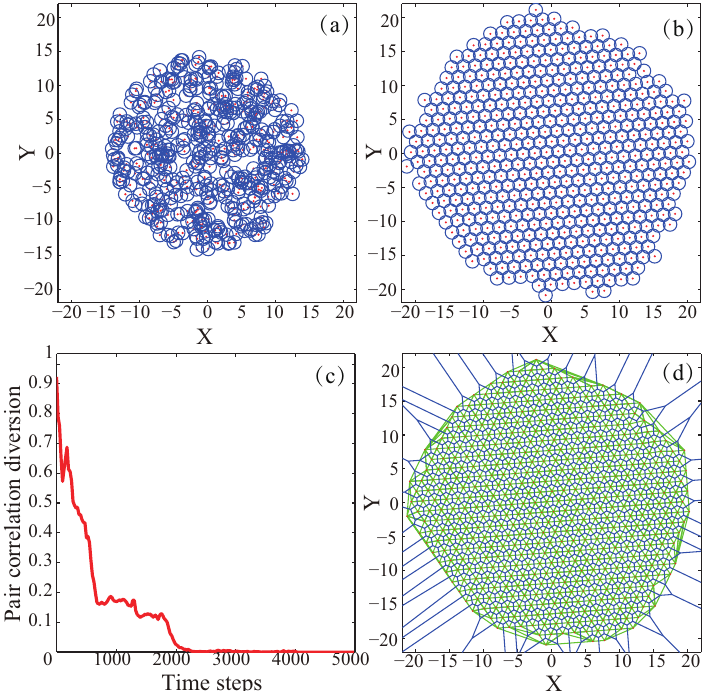
Figure 2. ( a ) Initial node distribution; ( b ) Final node distribution; ( c ) corresponding variation of pair correlation diversion as a function of time; ( d ) final network topology represented by using Delaunay triangulation method and Voronoi